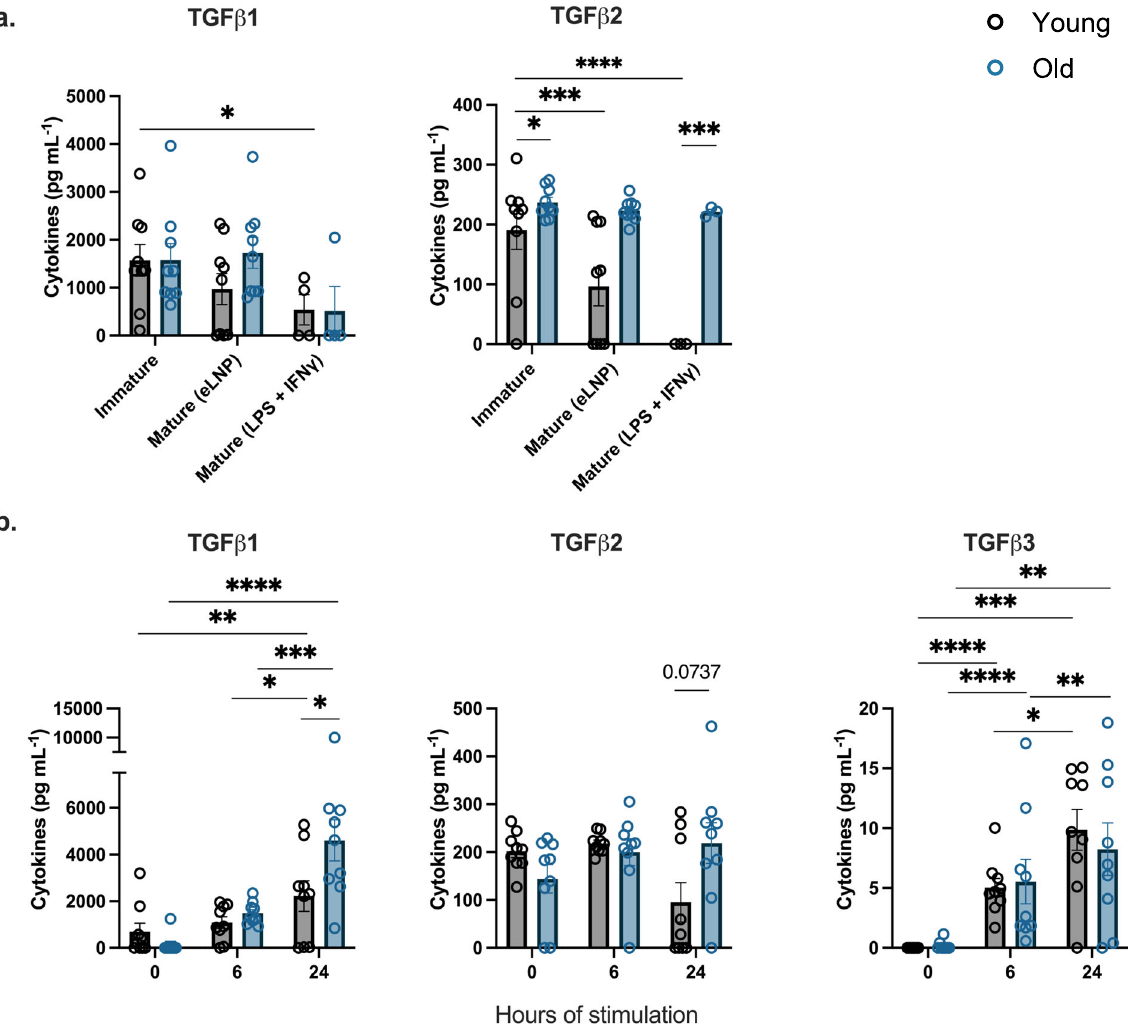
Fig. 7 eLNP treatment results in differential TGF- β secretion. a TGFB secretion after 24 h eLNP stimulation compared to that in unstimulated cells of MDDCs. n = 9. Data were combined from at least two independent experiments. b Dynamics of TGF-B secretion from PBMCS at 0, 6, and 24 h after eLNP stimulation. n = 9 for each group. Data are from one independent experiment (a,b) Each individual circle represents one individual subject. One-way ANOVA followed by Tukey ’ s test was applied in a . Non-parametric Mann Whitney T-test was applied in b . * P < 0.05, ** P < 0.01, *** P < 0.001, **** P <